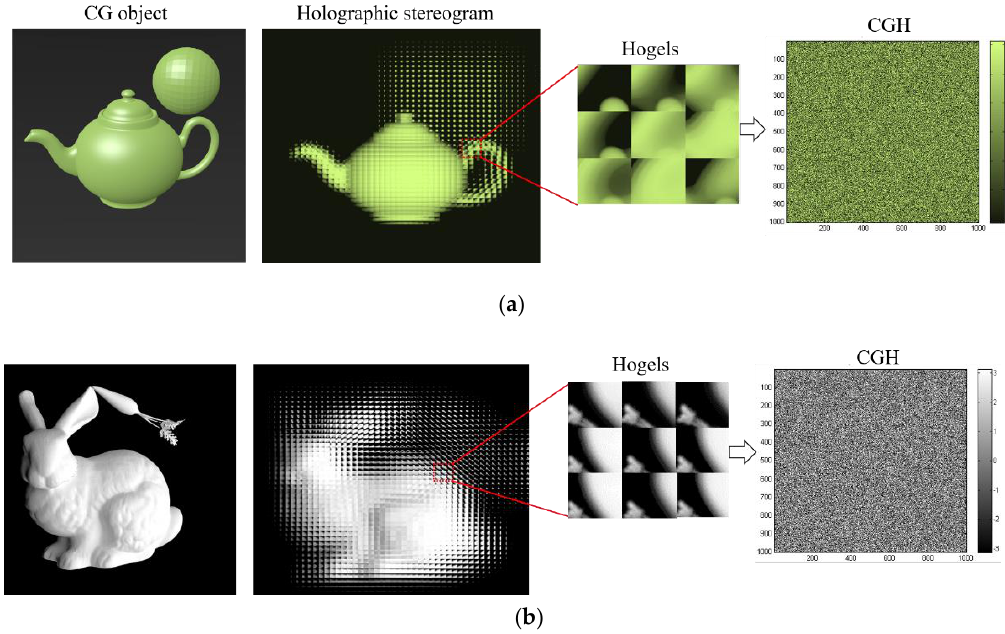
Figure 5. 3D scene and hologram synthetization from full-parallax HS: ( a ) 3D object “Teapot and sphere.” ( b ) 3D object “Bunny and carrot.”